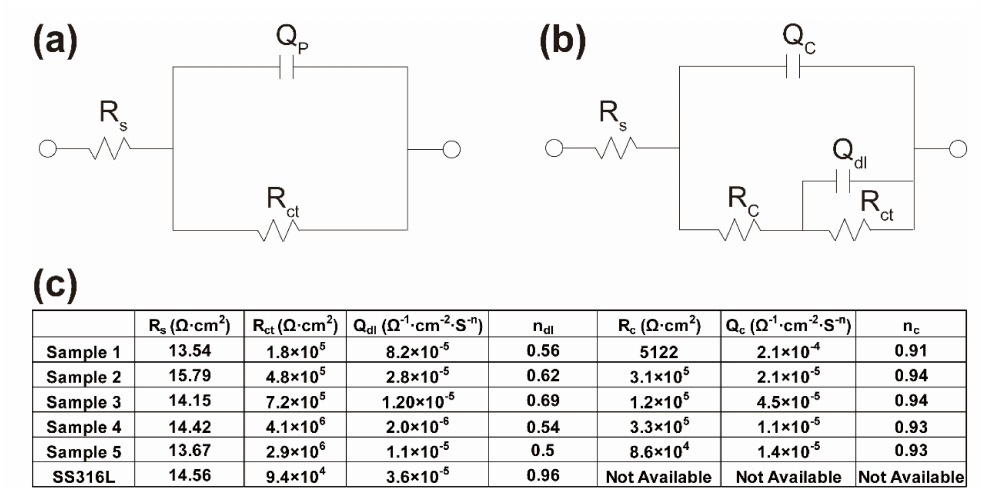
Figure 7. An equivalent circuit was used to simulate experimental EIS data of ( a ) R S (Q P R ct ) and ( b ) R S (Q C R C (Q dl R ct )). ( c ) Fitted data based on the equivalent electrical